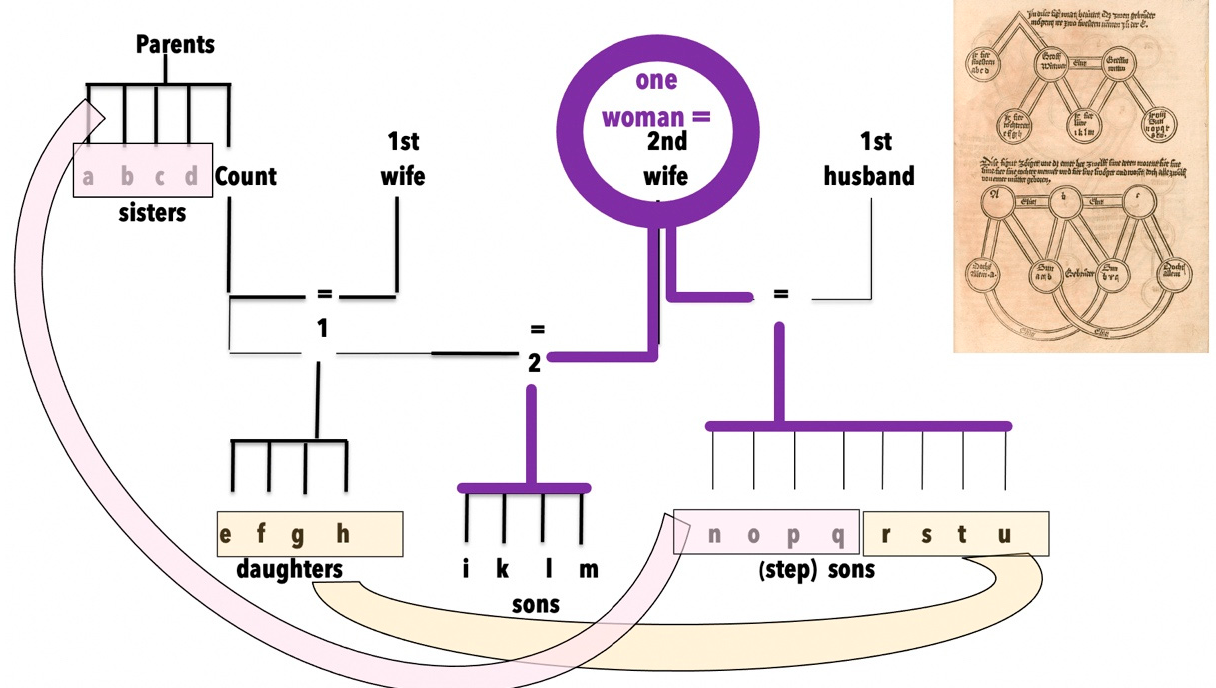
Figure 4. The solution to the riddle of the count with the twelve knights who were his sons, brothers- in-law or sons-in-law, all born of one woman. Drawing credit: Lyndan Warner. Inset: Johannes Andreae, Super arboribus consanguinitatis et affinitatis , Strasbourg: Heinrich Knoblochtzer, c. 1482/3, 10 r . Attribution: Bayerische Staatsbibliothek, Munich, Germany. CC BY-NC-SA 4.0. At some point, a kinship riddle made the transition from a law book challenge to a painting. In the Riddle of Nijmegen attributed by the Museum Het Valkhof to Cornelis Ketel, a young woman at the centre of the painting looks directly at the viewer (Figure 5; Ketel 1576). She is surrounded by a group of males of various ages, from boys to a weak old man. Inserted into the indoor scene are a series of cartouches with text labelled A to E. Lying across her lap, an old man draws attention to cartouche A. The text, inscribed on a wooden chest, invites the viewer to solve a ‘subtle’ riddle and dates the painting to 1576.